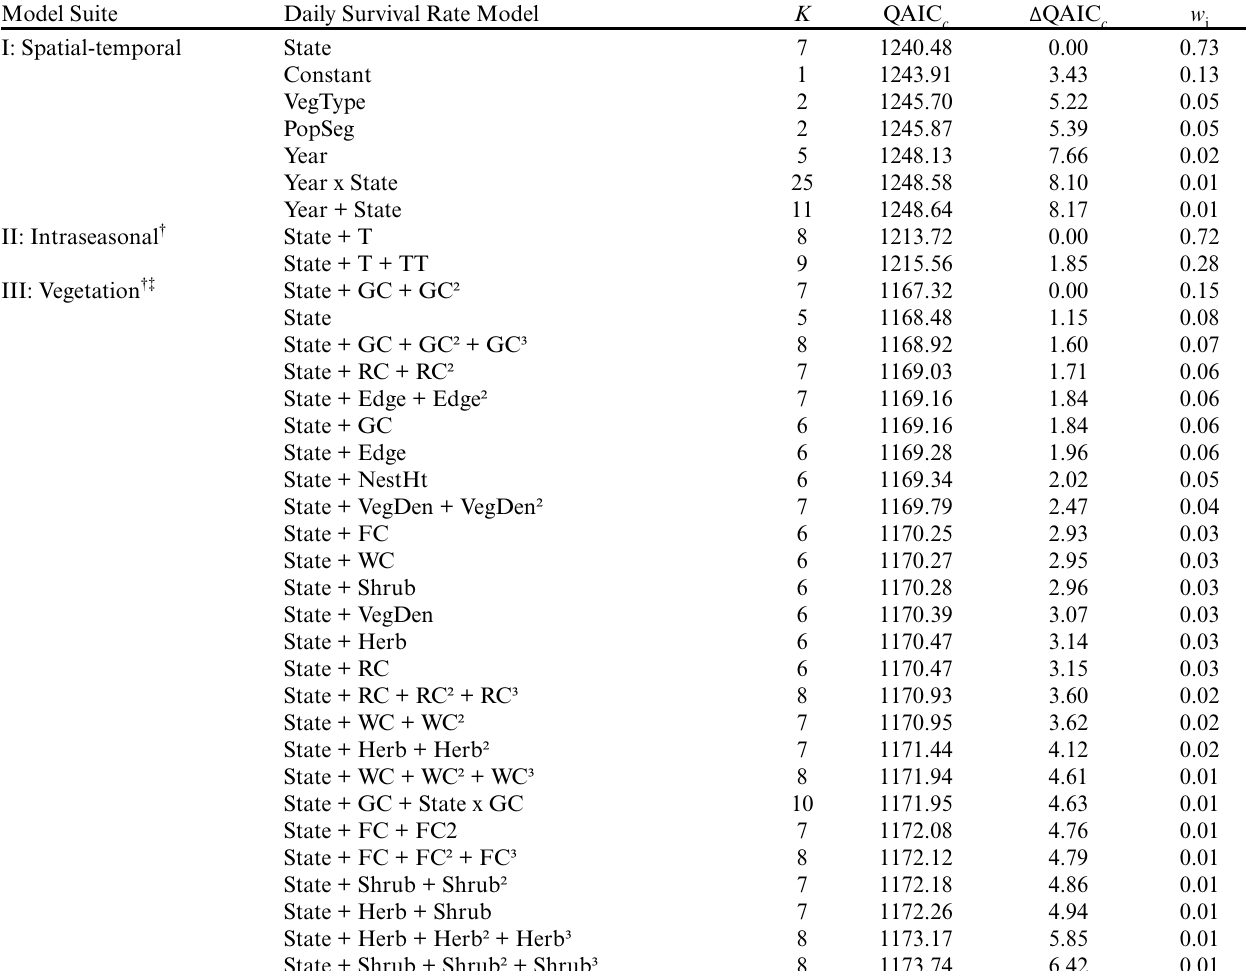
Table 3 . Model-selection results for daily survival rate of Golden-winged Warbler ( Vermivora chrysoptera ) nests from Model Suites I, II, and III in Minnesota, Wisconsin, New York, Pennsylvania, West Virginia, North Carolina, and Tennessee, 2008-2012. We used program MARK (ver. 7.1, Colorado State University, Ft. Collins, Colorado, USA) and Akaike’s Information Criterion adjusted